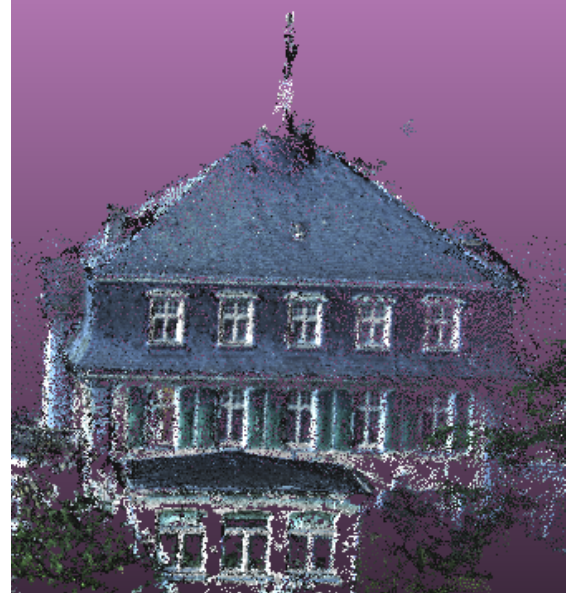
Figure 7: Photogrammetric point cloud of the Frankenforst manor in Vinxel/ Germany captured by our